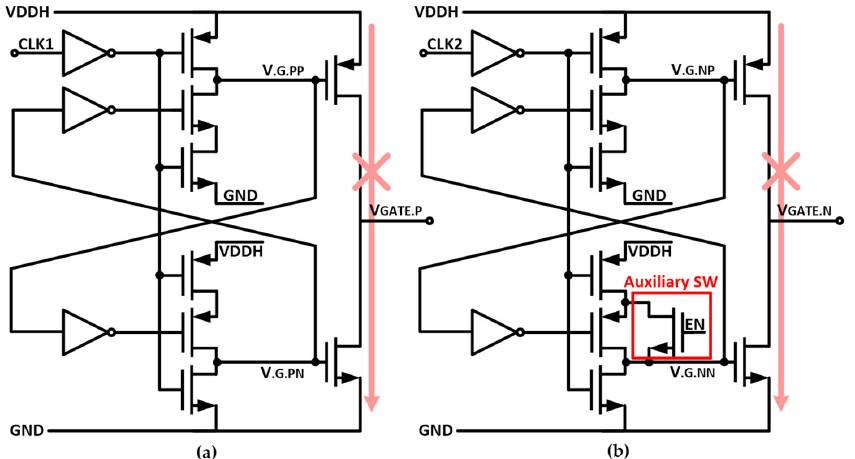
Figure 7. Circuit implementation of the proposed gate driver with reduced dynamic current: ( a ) gate driver for the high-side switch, ( b ) gate driver for the low-side switch. driver for the high-side switch, ( b ) gate driver for the low-side